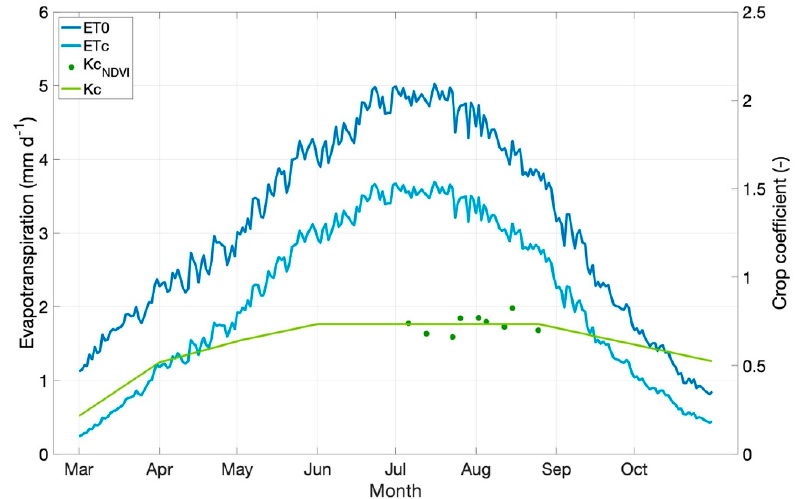
Figure 4. Values of ETo, ET C and Kc estimated for the period March–October 2018.